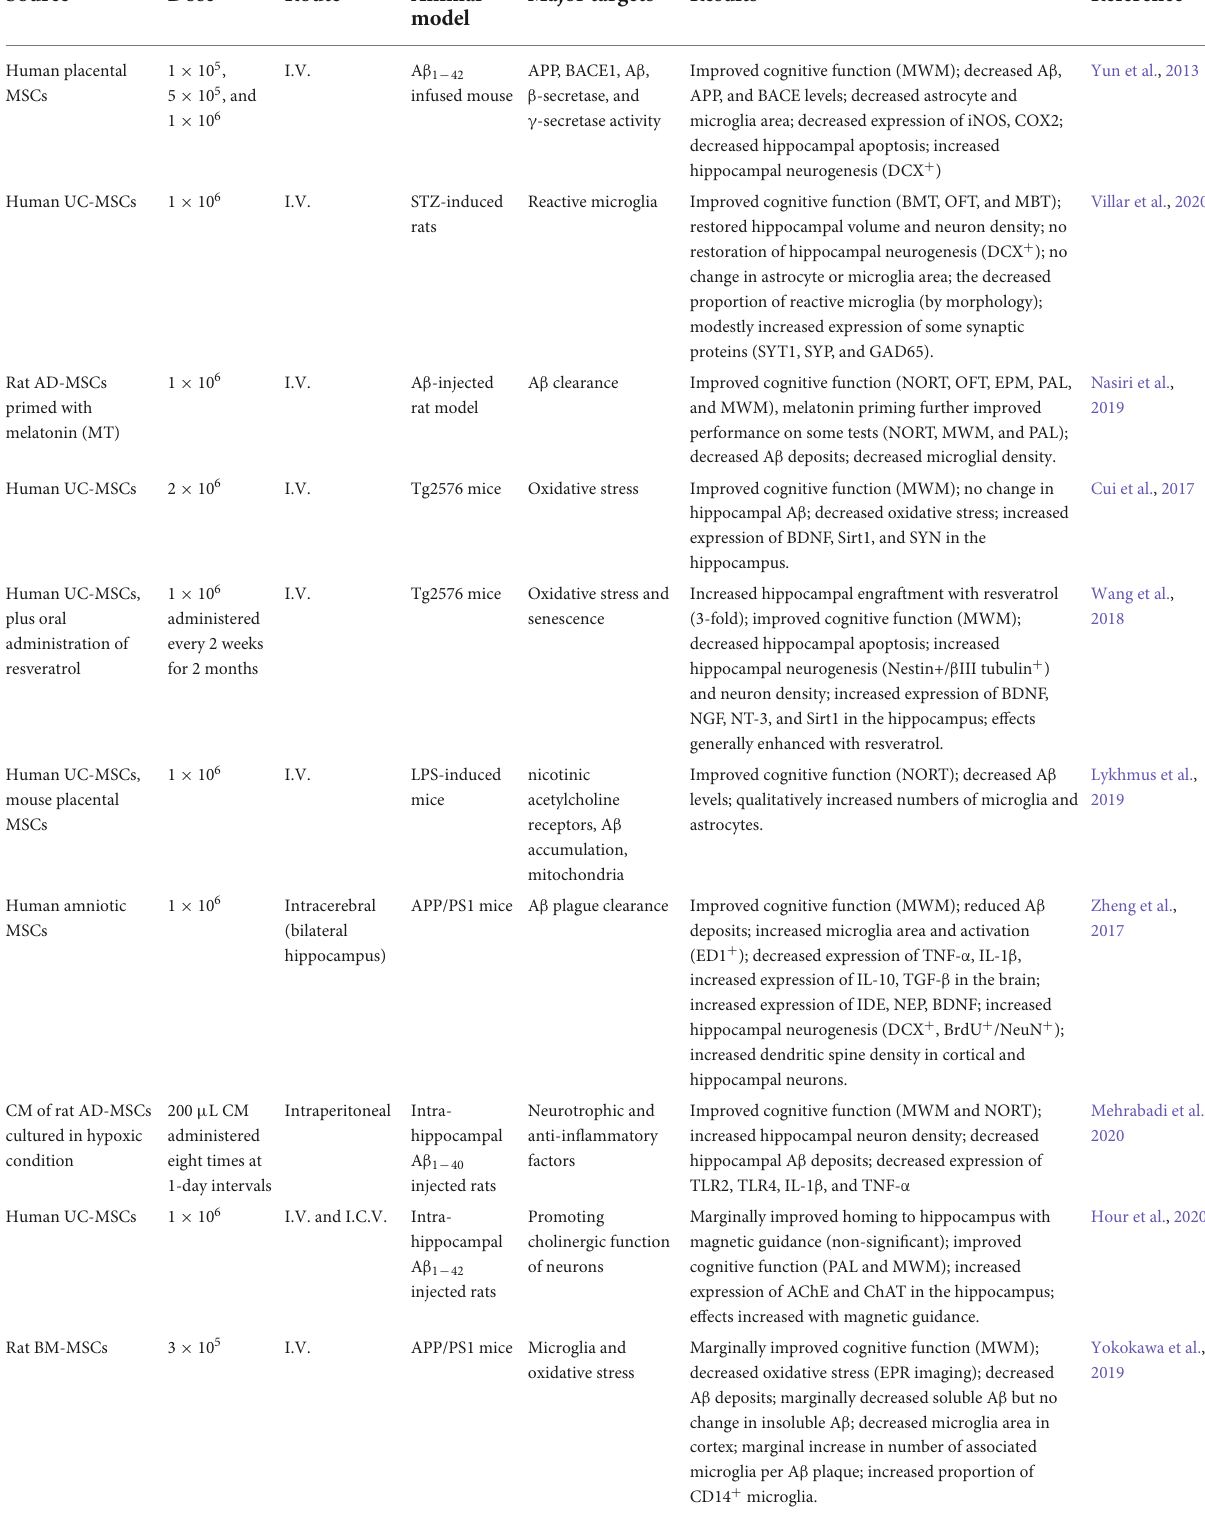
TABLE 1 Application of MSCs for Alzheimer’s disease in preclinical